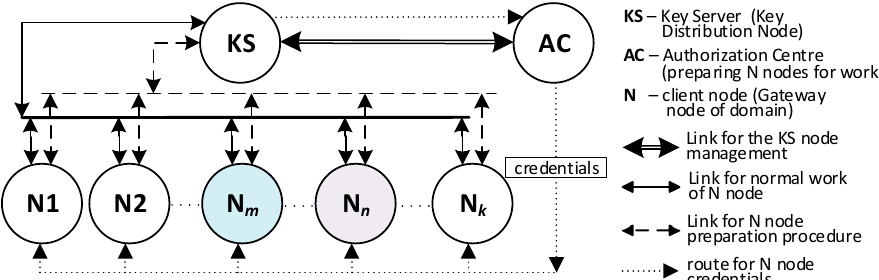
Figure 3. The method of data exchange in the Key Generating and Renewing (KGR) system.